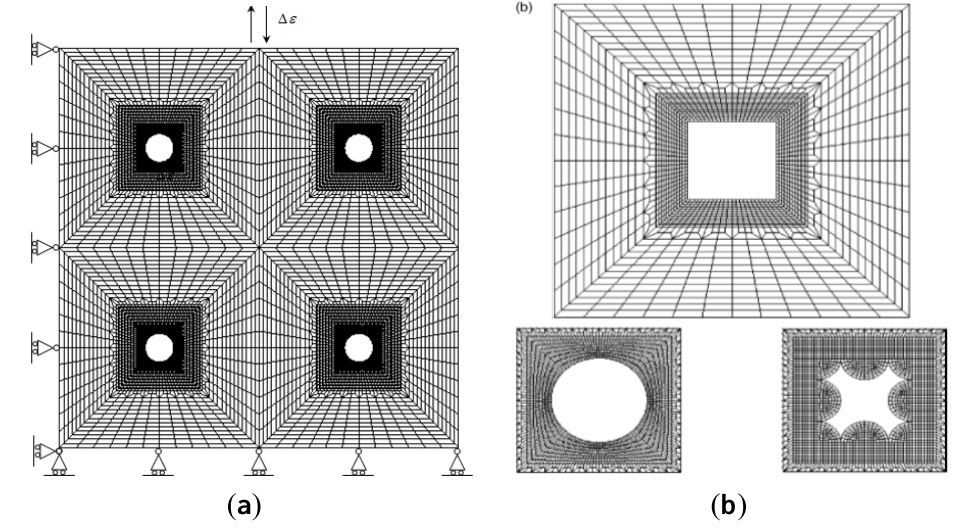
Figure 16. ( a ) Overall view of the plate with micro-defects and mesh configuration; ( b ) Defect shape [7].